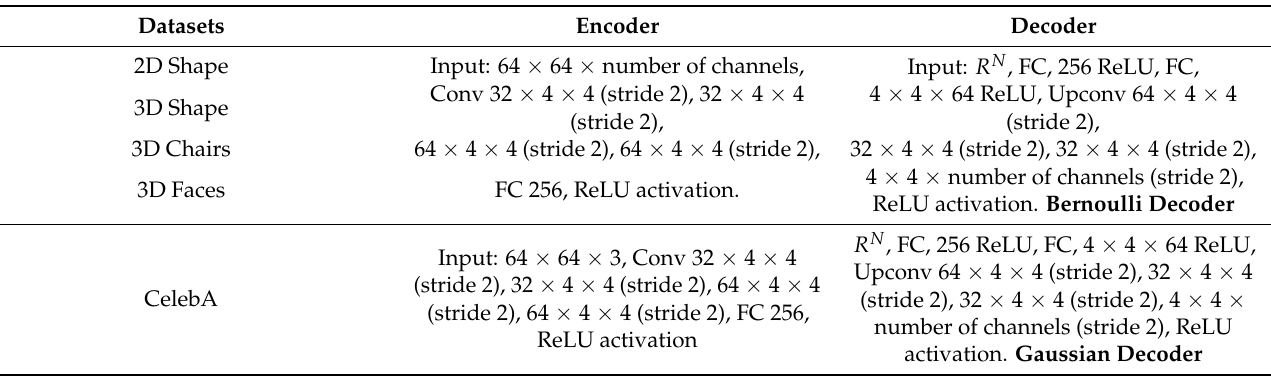
Table 3. Details on the encoder and decoder architecture used to implement methods discussed in this paper depending on the chosen